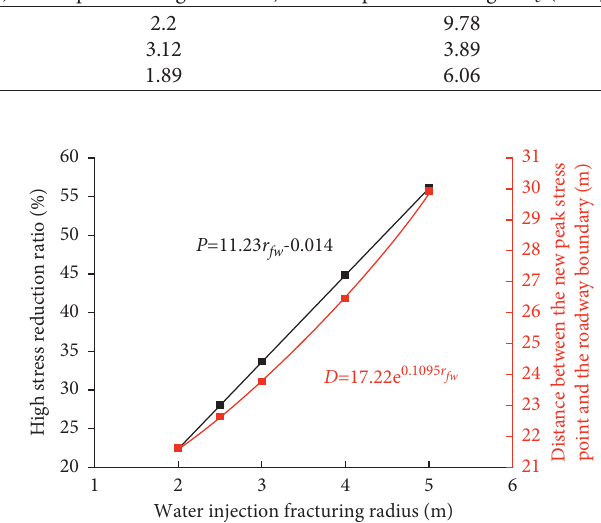
Figure 7: Hydraulic fracturing effect under different water in- jection fracturing